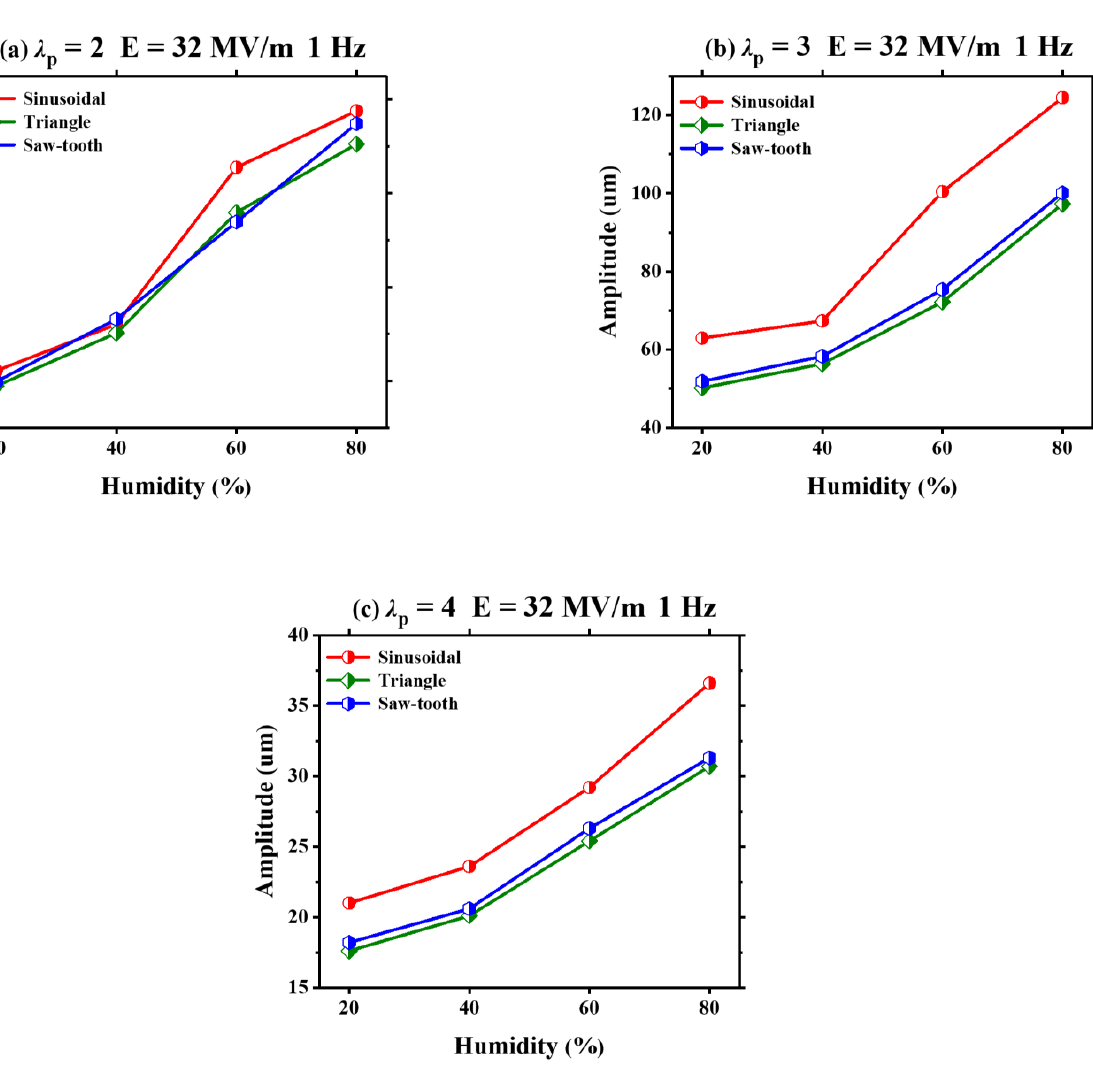
Figure 6. Under different pre-stretch ratios ( λ p = 2, λ p = 3, and λ p = 4), the humidity effect on the amplitude of the VHB 4905 film with different voltage waveforms (sinusoidal, triangle and saw-tooth).